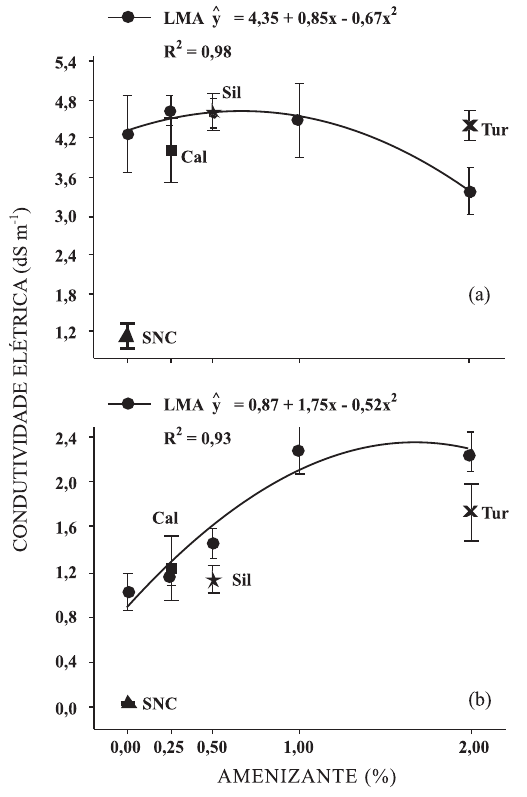
Figura 2. Condutividade eletrolítica (dS m -1 ) nos lixiviados do Neossolo Quartzarênico (a) e do Latossolo Vermelho (b) contaminados com Cd e Pb coletados no término do experimento. LMA: lama da mineração de Al, SNC: solo não- contaminado, Cal: calcário, Sil - silicato e Tur: